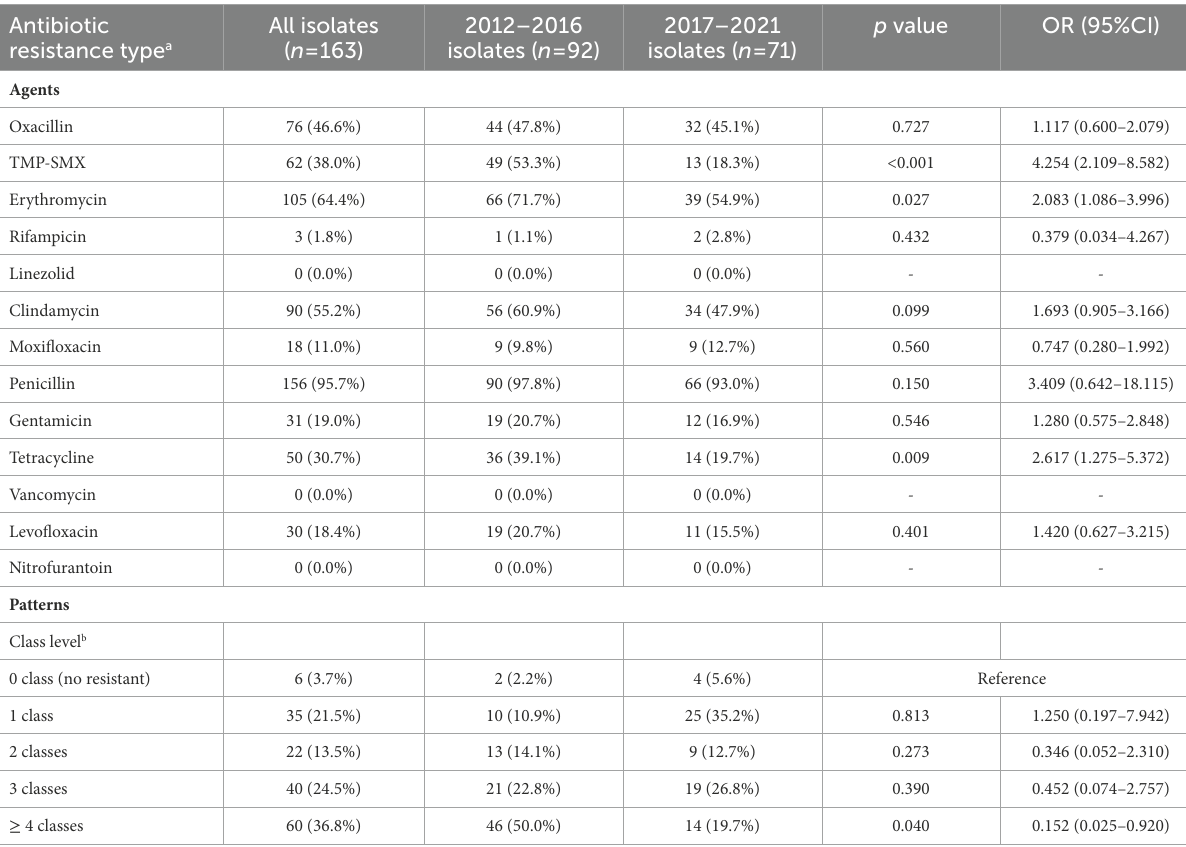
TABLE 3 Antibiotic resistance of Staphylococcus aureus among 2012–2016 isolates and 2017–2021